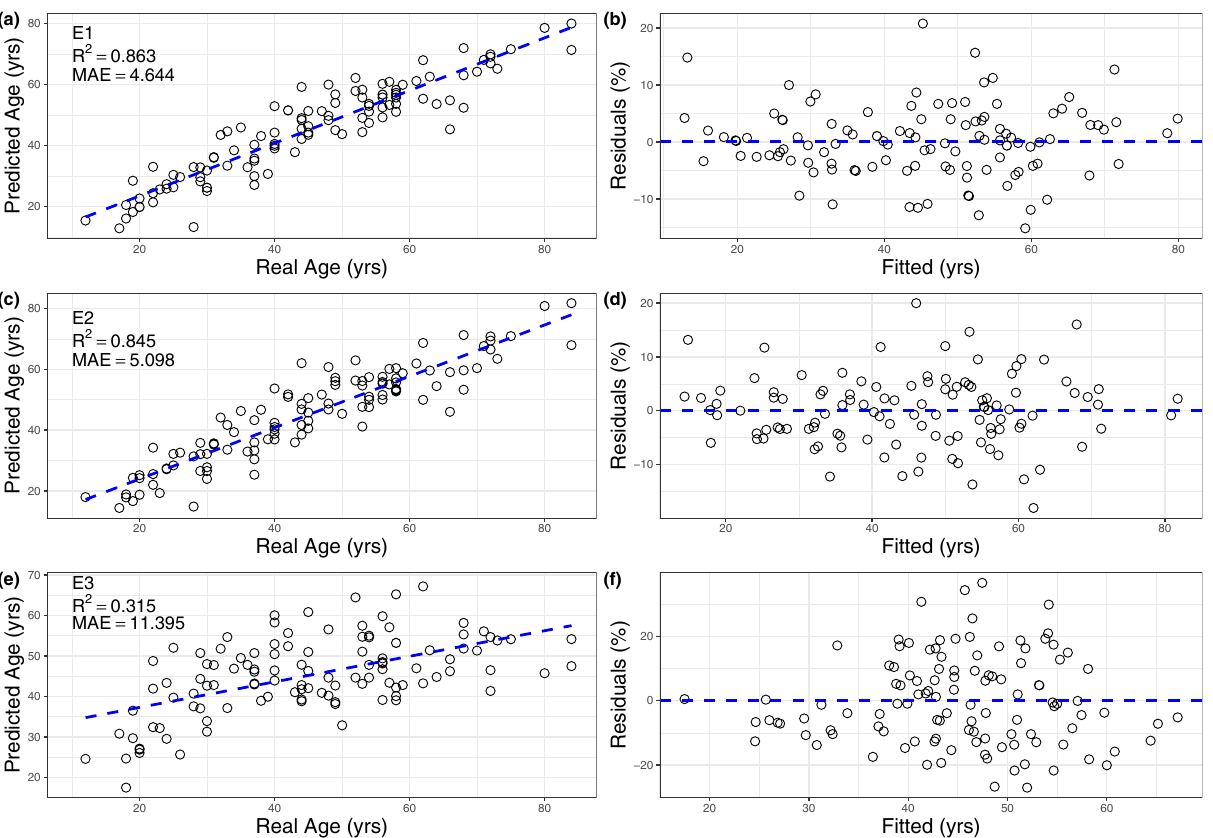
Figure 1. Regression diagnostic plots for the three models. Regression plots presenting the relationship between real age and predicted age for E1 ( a ), E2 ( c ) and E3 ( e ). It is possible to see that there is minimal difference between predicted age for different age ranges. Distribution of residuals is homogeneous for E1 and E2 ( b and d ), while E3 does not show regular residuals distribution ( f ).